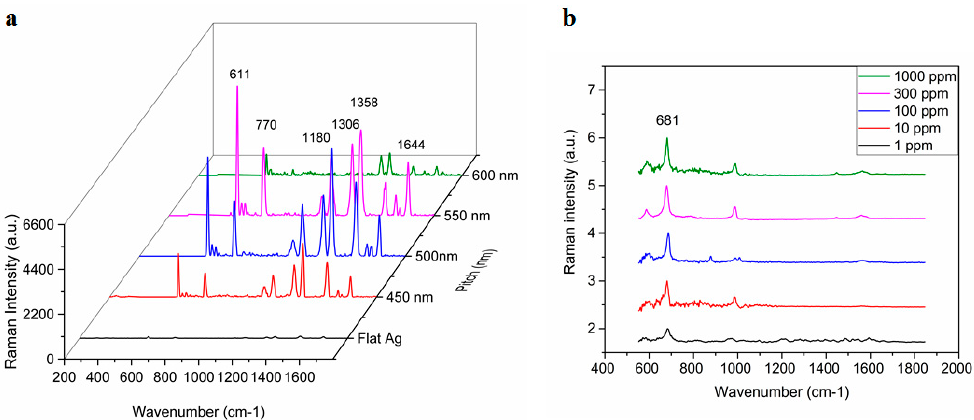
Figure 3. Surface-enhanced Raman scattering (SERS) activity of Ag TS-CSRG. ( a ) Pitch-dependency of SERS spectra for R6G (10 –5 M) with pitches ranging 450 nm to 600 nm, and for a flat Ag substrate for R6G (10 –2 M). ( b ) Average SERS spectra of melamine on Ag TS-CSRG for concentrations ranging from 1 ppm to 1000 ppm.